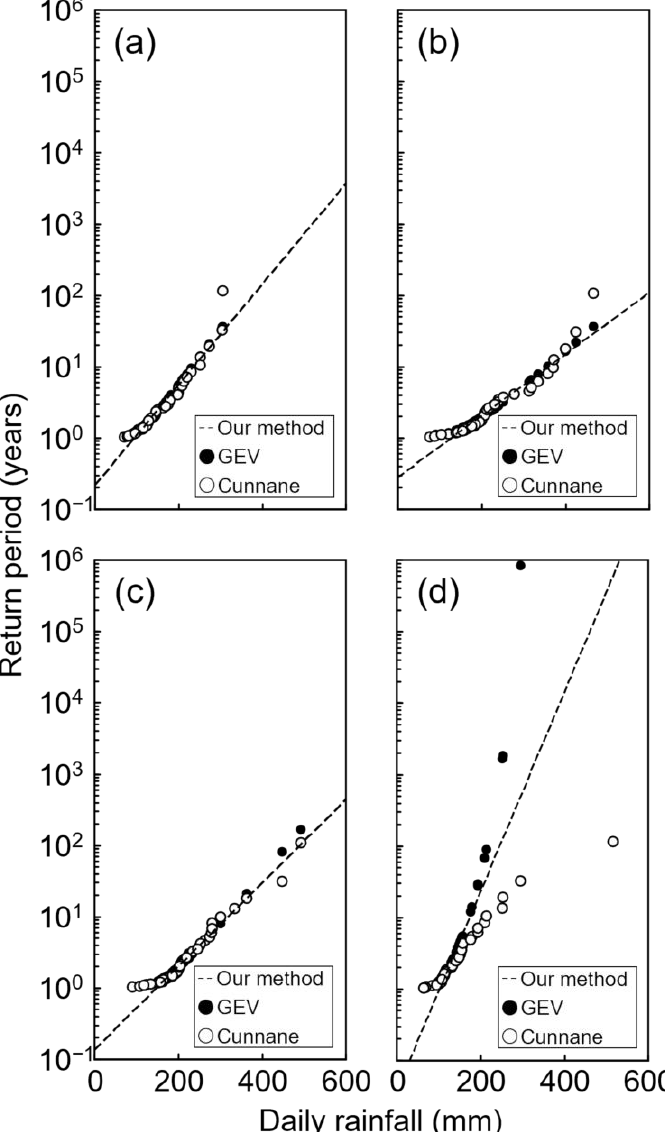
Figure 8. Comparison of RP estimated by the proposed regression equation, RP estimated by the GEV, and RP by the empirical method (Cunnane [39]) at AMeDAS Izumi ( a ), Morotsuka ( b ), Aso-Otohime ( c ), and Asakura ( d ).